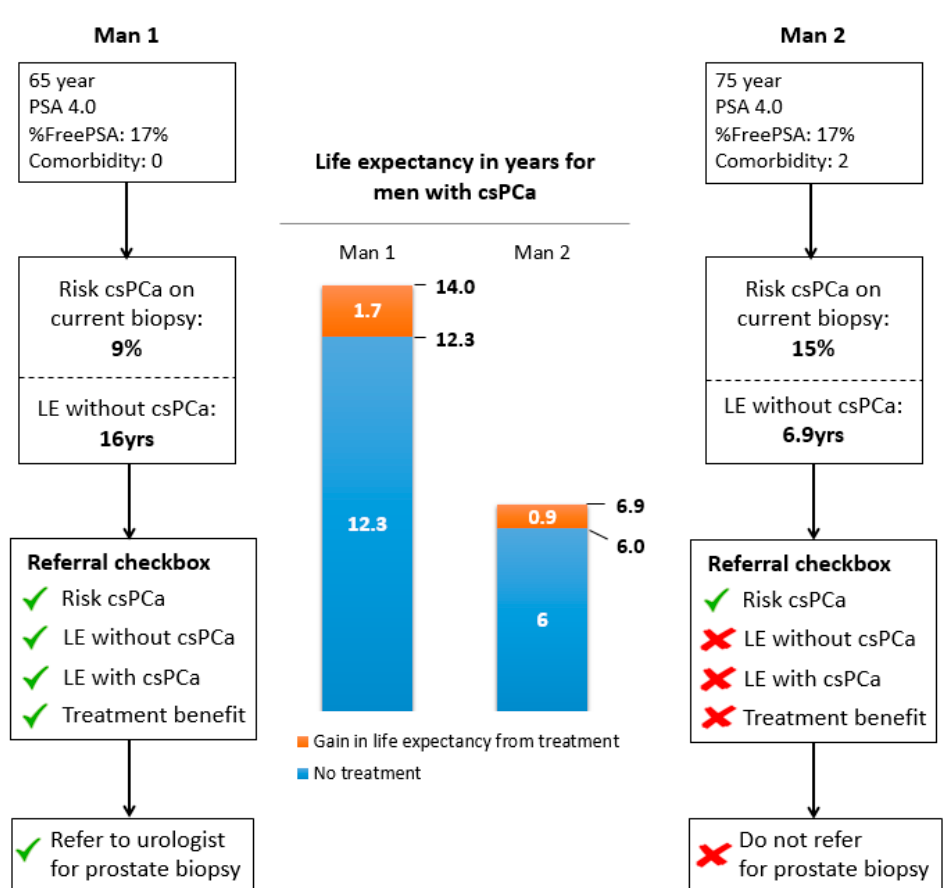
Figure 3. Output of the prediction tool for the general practitioner (GP). Displaying risk of clinically significant prostate cancer (csPCa; Gleason score ≥ 3 + 4) on a current biopsy, LE in years with and without csPCa, treatment benefit in years, and referral advice in two male examples.